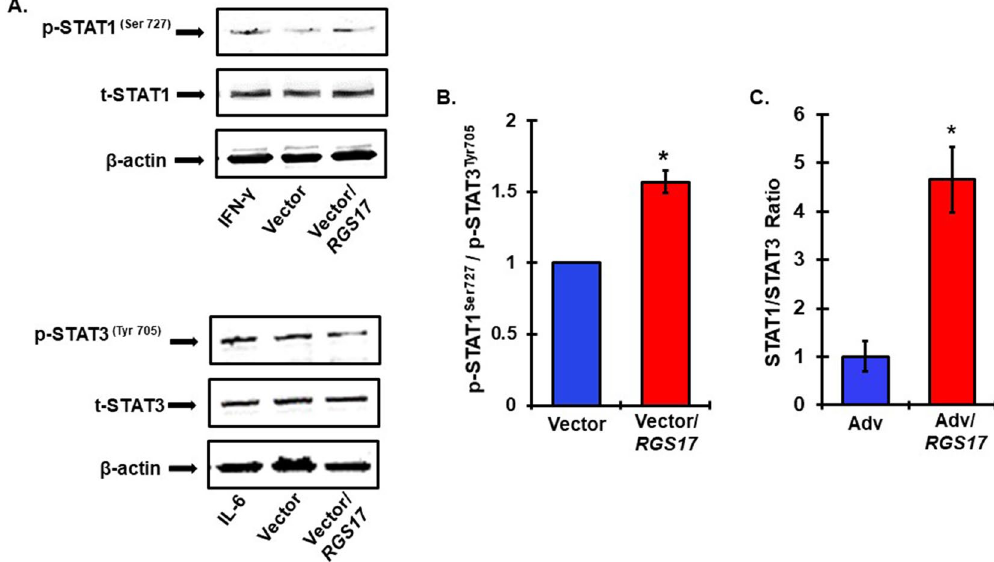
Figure 6. RGS17 increases STAT1/STAT3 ratio in vivo and in vitro. ( A ) UB/OC1 cells were transiently transfected with control vector or RGS17 plasmid for 72 h. Cells were treated for IFN-γ and IL-6 for 45 min as positive control for STAT1 and STAT3 respectively. Cell lysates were prepared for western blot analyses of Ser 727 p-STAT1, Tyr 706 p-STAT3, t-STAT1 and t-STAT3 for normalization and β-actin for loading control. RGS17 overexpression increased p-STAT1 activation and decreased p-STAT3 activation (Below). ( B ) Graphical representation showing RGS17 overexpression increased the STAT1/STAT3 ratio. Data presented as the mean ± SEM. (N = 5). Asterisks *p < 0.01 versus vector, t-test. ( C ) RNA was collected from the whole cochleae of rats treated with empty adenoviral vector or adenoviral vector with RGS17 transgene. Expression of STAT1 and STAT3 was assessed via real-time qPCR analysis RGS17 overexpression in rat cochlea significantly increased STAT1/STAT3 ratio. Data indicate mean ratio computed from observed fold change in the mRNA levels ± SEM (N = 4). *p < 0.05 versus Adv and analyzed by